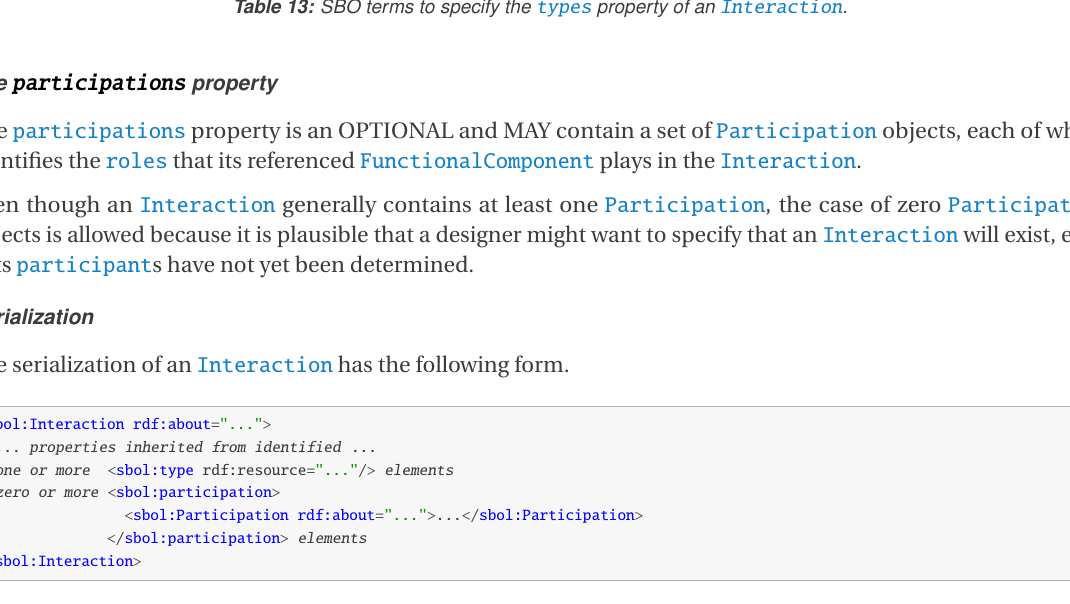
Table 13: SBO terms to specify the types property of an Interaction